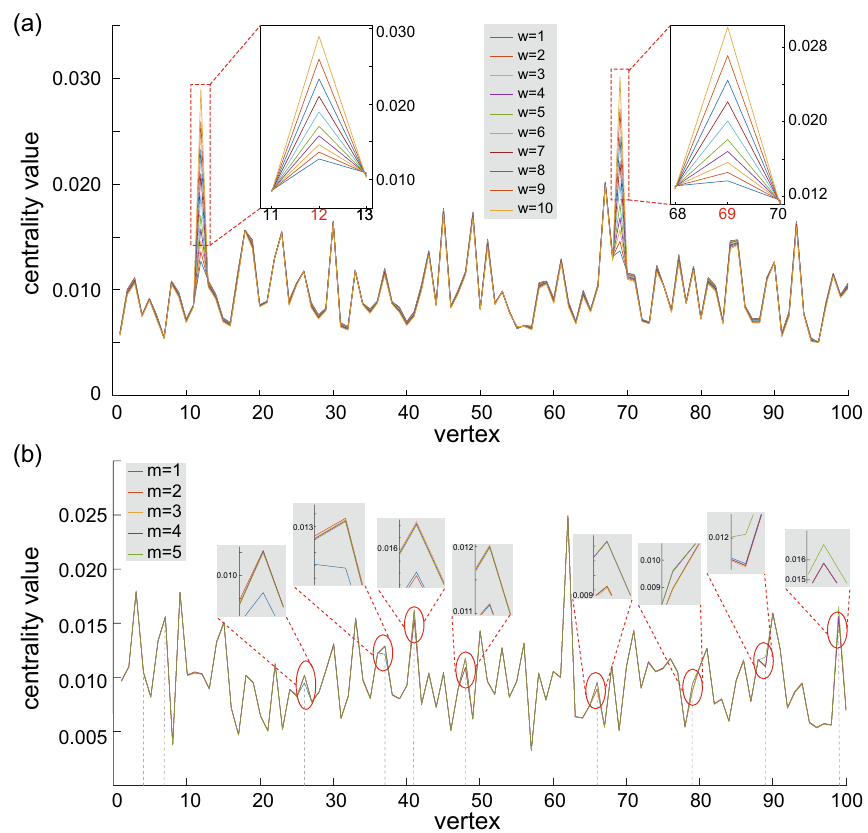
Figure 5. ( a ) CTQW-based centralities on an ER (100, 0.3) by traversing weight of an edge from 1 to 10. The randomly chosen edge connects vertex 12 and 69. The inset graphs show details of centrality changes near vertex 12 and 69. ( b ) More weighted edges on Erdős-Rényi graphs ER (100, 0.3). The number of weighted edges, m , ranges from 1 to 5, and the weight w = 2 is added to the edge (4, 7), (26, 37), (41, 48), (66, 79) and (89, 99) in succession. The vertical dotted lines show the endpoint vertices of edges with additional weights. The inset graphs give details of centrality changes near these endpoint